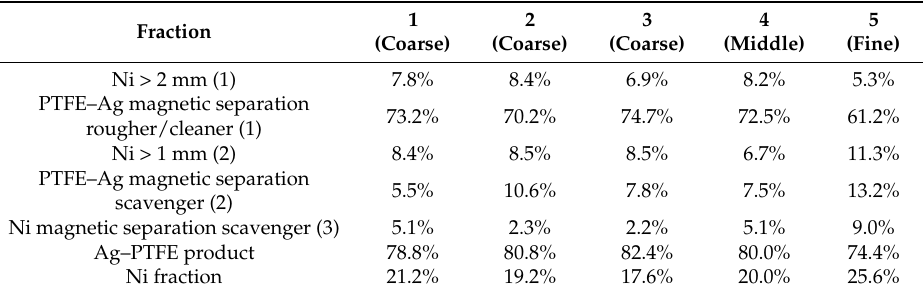
Table 1. Mass recoveries of mechanical processing tests.